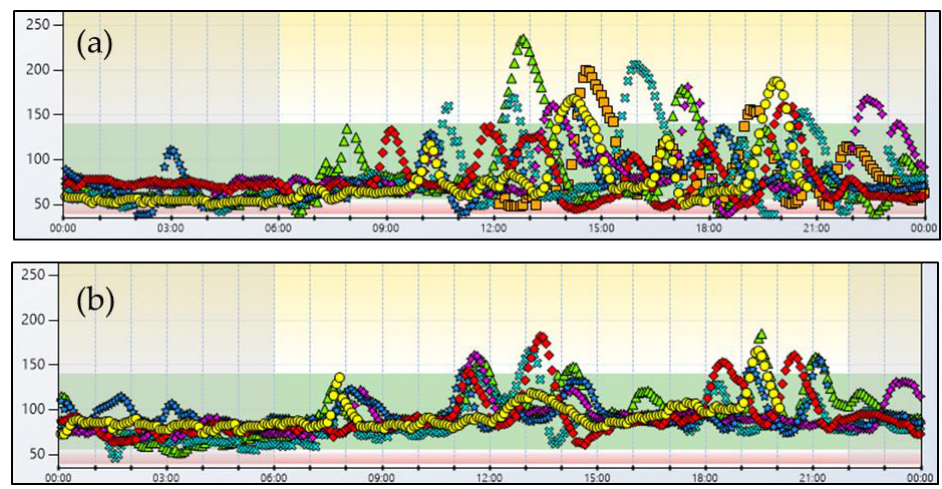
Figure 1. Case 1. 7-day glucose profile before ( a ) and after ( b ) nutritional intervention. Table 1. Time spent at different glucose levels and indexes of glucose variability obtained through Continuous Glucose Monitoring (CGM) before and after nutritional management. Case 1 Case 2 Before After Δ %